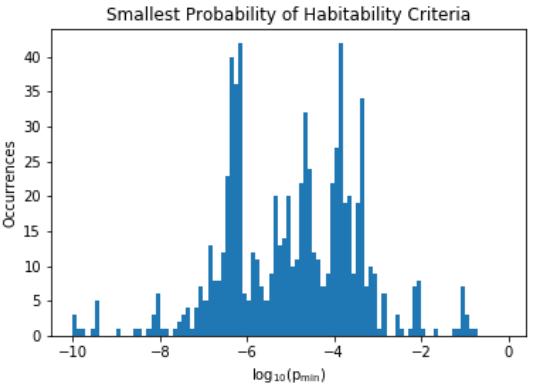
Figure 5. The smallest probability of the combinations of the 756 habitability criteria considered. All combinations of 3 or less criteria discussed in this paper and the previous four in this series are included. The probabilities considered are of observing the five physical constants being varied, as well as the probability of orbiting a star of solar mass and witnessing our organic-to-rock